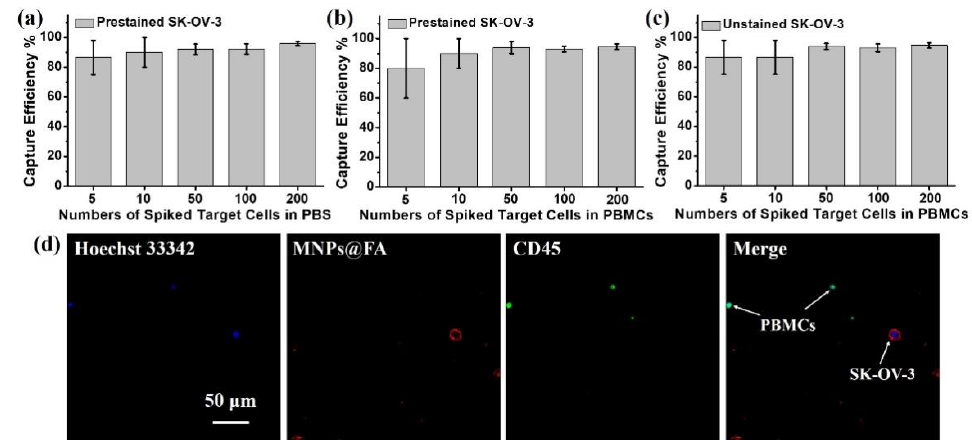
Figure 5. ( a ) The capture efficiency of MNPs@FA for rare DiI prestained SK-OV-3 cells in 1 mL of PBS. ( b ) The capture efficiency of MNPs@FA for rare DiI prestained SK-OV-3 cells in 1 mL of pre-treated PBMCs solution. ( c ) The capture efficiency of MNPs@FA for unstained SK-OV-3 cells in 1 mL of pre-treated PBMCs solution. All data are expressed as the mean ± stand deviation, n = 3. ( d ) Fluorescent images of MNPs@FA combined anti-CD45-488 and Hoechst 33,342+ for target